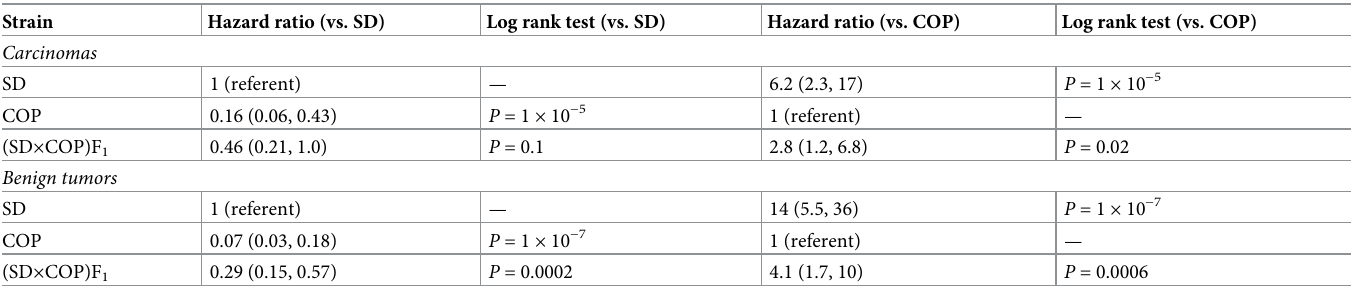
Table 4. Hazard analysis of palpable mammary tumors among strains. Strain